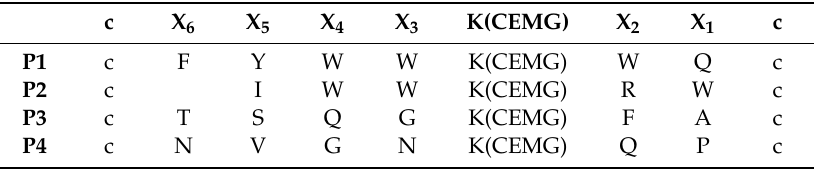
Table 1. Sequences of cyclic positive illuminating peptide